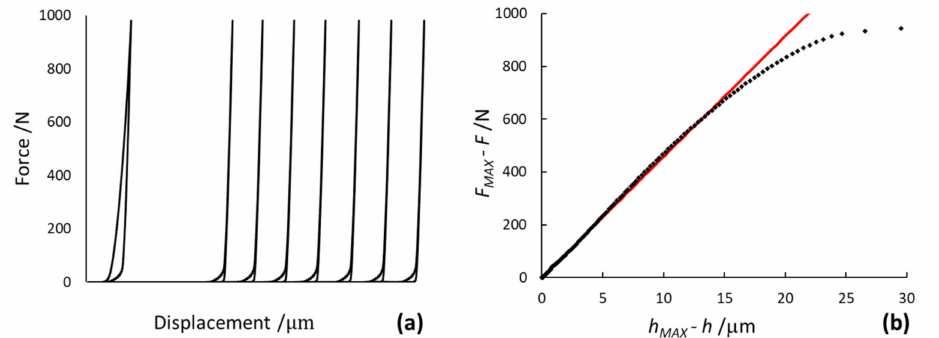
Figure 5. Series of loading and unloading cycles of the indentation curve at a single point ( a ); and the linear regression of the last reversed unloading curve for the HV100 procedure ( b